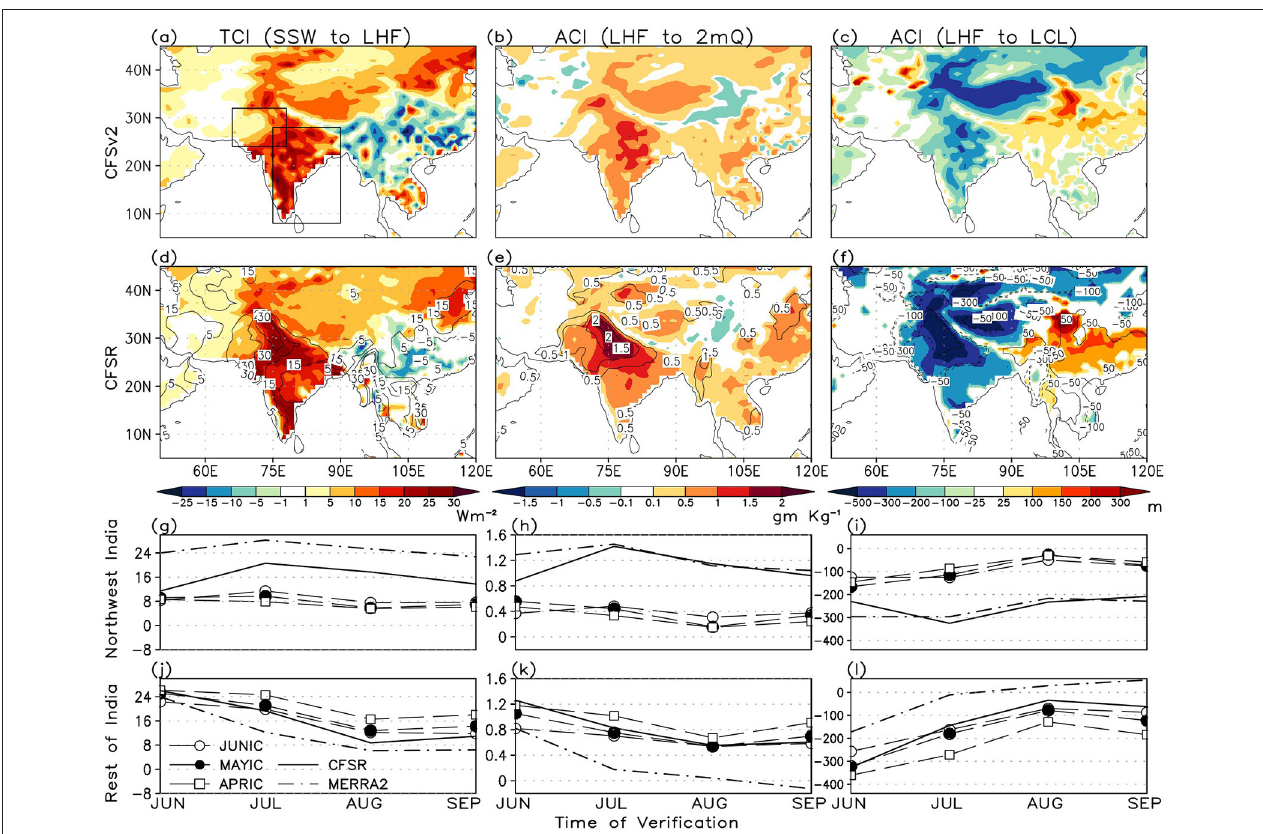
FIGURE 7 | (a) Terrestrial coupling index (TCI) for 2m specific humidity (2 mQ) based on SSW and LHF and (b) the corresponding atmospheric coupling index (ACI) based on LHF and 2 mQ, from CFSv2 JUNIC hindcasts. (c) shows the ACI for LCL height. Units are Wm − 2 , gm Kg − 1 , and m, respectively. (d–f) respectively, shows the same for CFSR (shaded) and MERRA2 (black contours). (g–i) and (j–l) show the monthly coupling indices in JJAS for the northwest and rest of India domains, respectively; from JUNIC, MAYIC and APRIC hindcasts, CFSR and MERRA2.